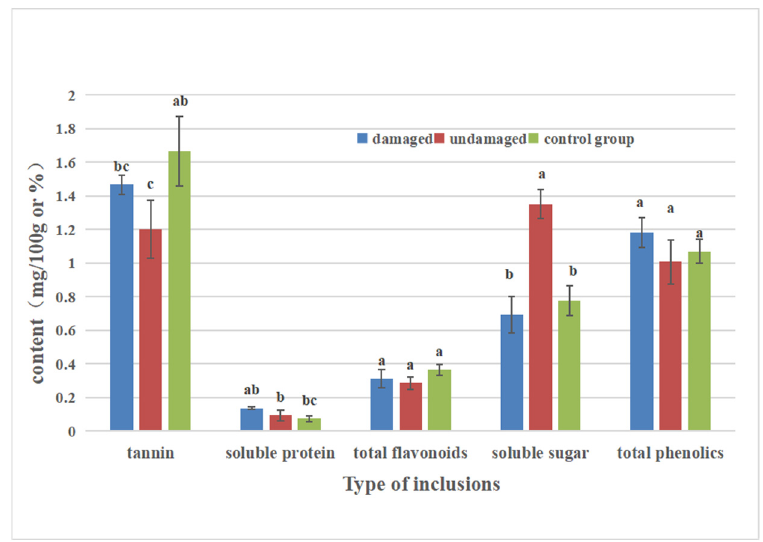
Figure 1. Contents of secondary biomass and nutrients in host plant leaves affected by C. ciliata .